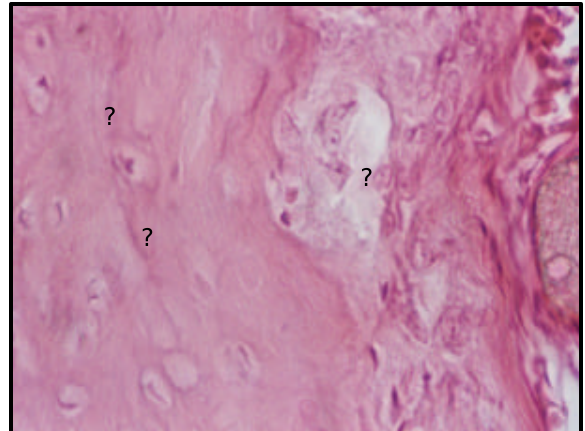
FIGURA 3 - Tecido ósseo neoformado ( ? ) rico em osteócitos ( ? ) e delimitado por tecido conjuntivo denso( ? ). HE